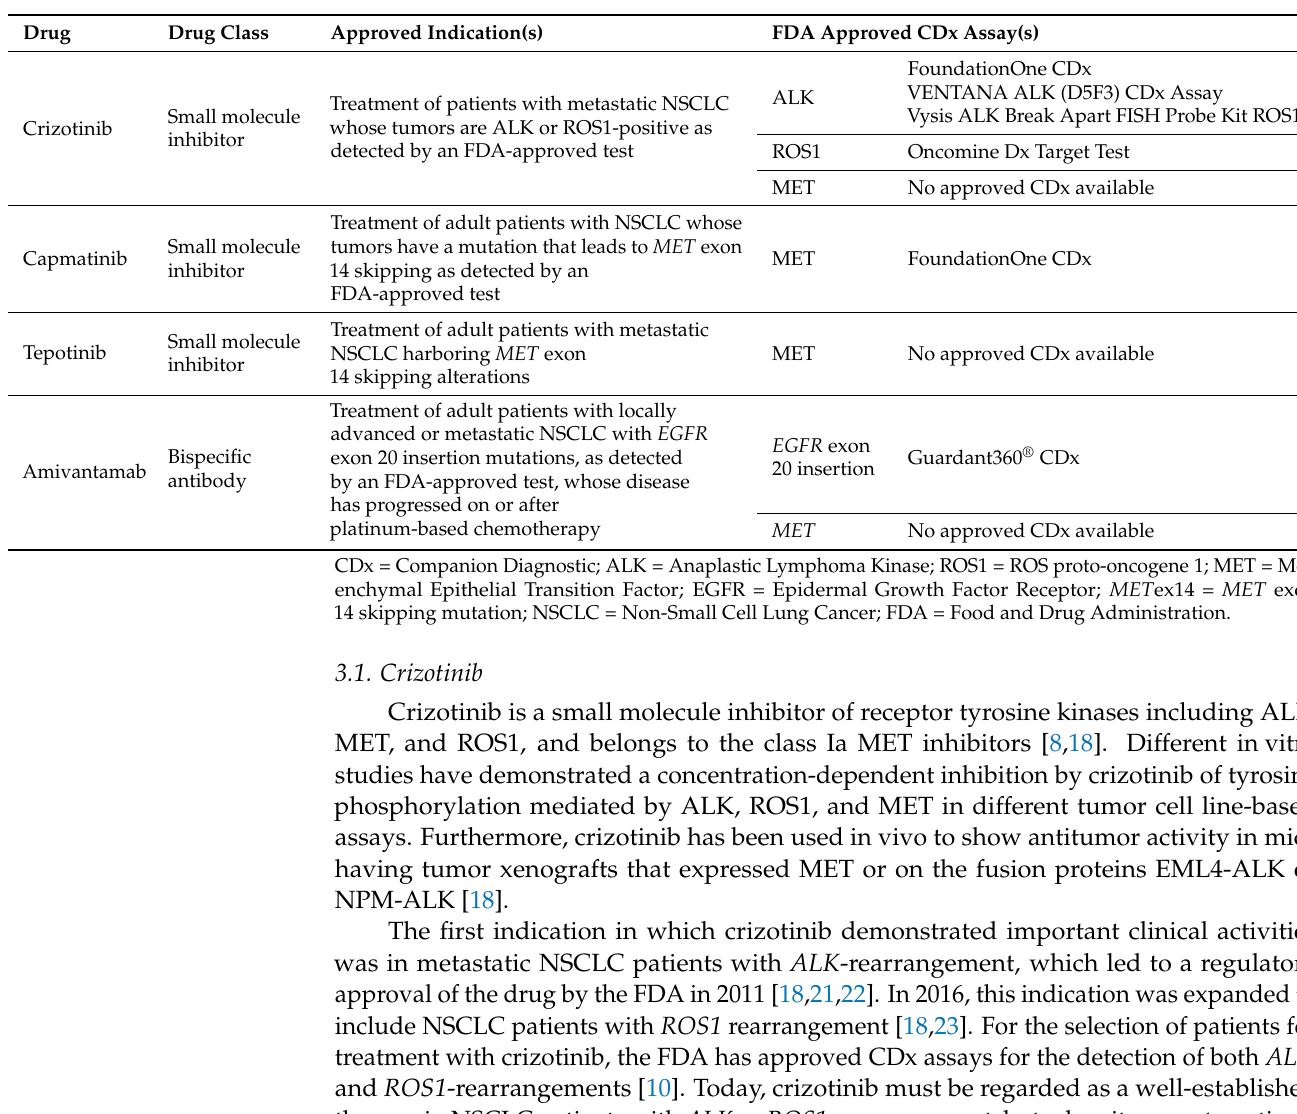
Table 1. FDA-approved MET targeted drugs and their CDx assays. Only capmatinib and tepotinib are approved for a MET-specific indication